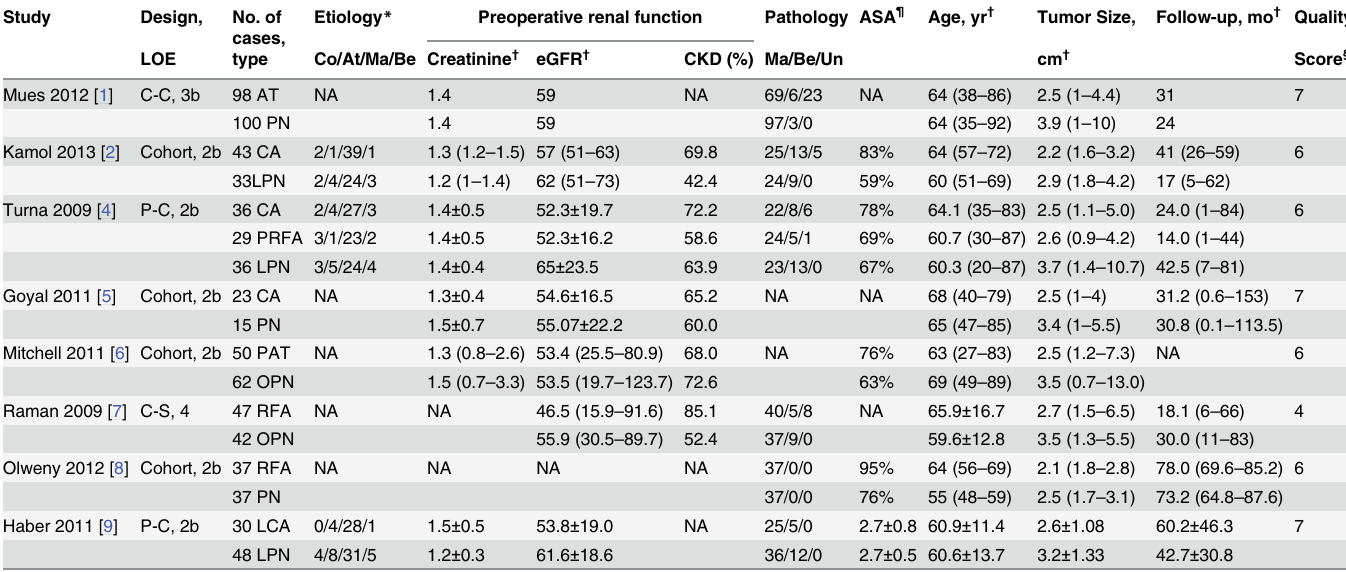
Table 1. Baseline characteristics of included